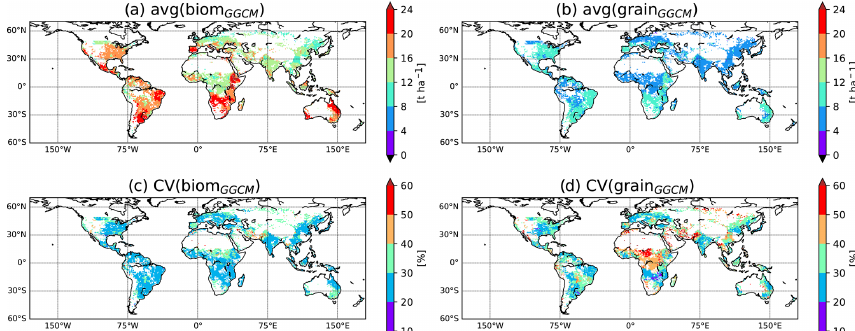
Figure 1. GGCM divergence in simulation of potential aboveground biomass and yield. Average and coefficient of variation for both above- ground biomass (biom) and yield (grain) computed among eight GGCMs used in the current analysis for simulations approaching poten- tial yield in GGCMI (i.e., harmnon × irrigated for LPJ-GUESS, LPJmL, CLM-crop, pDSSAT, pAPSIM, GEPIC, and EPIC-IIASA and default × irrigated for CGMS-WOFOST; see Sect. 2.2.1). Only grid cells common to the eight GGCMs are considered for this figure. For GEPIC and EPIC-IIASA, the variable biom has been corrected (see Sect. 2.2.1). For the comparison including GGCMs that provide biom and grain for harmnon × irrigated simulation in GGCMI but which are not part of the current paper (i.e., EPIC-BOKU, PEPIC, and PEGASUS), see Fig. S1 in the